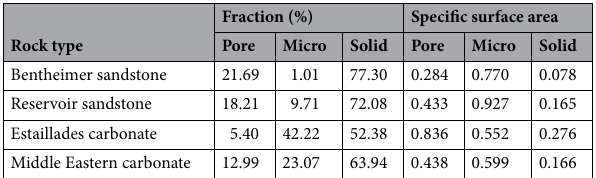
Table 3. Fraction distribution for the different rock images used in the noise sensitivty